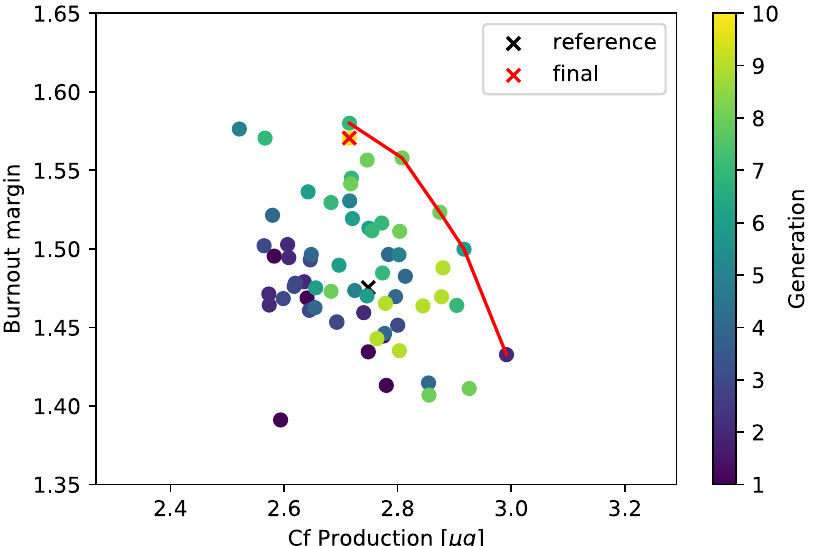
FIGURE 4. Evolution of first-day metrics with each generation for a low-density, centered and symmetric silicide fuel. The red line denotes the Pareto front. The red ‘x’ denotes the final shape